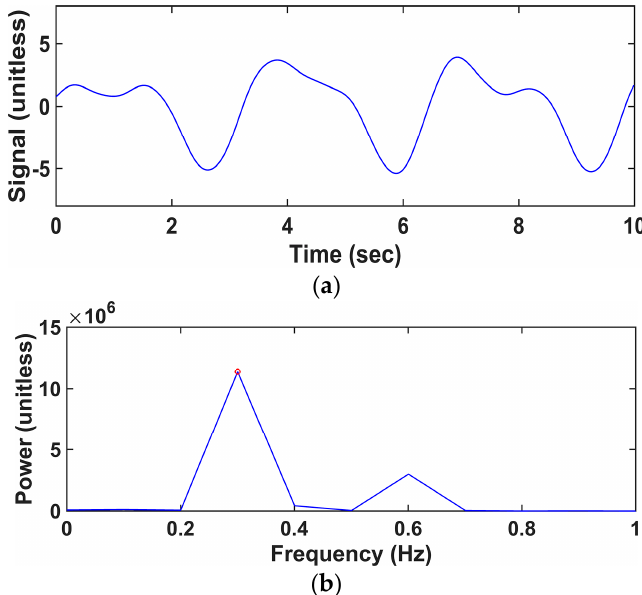
Figure 1. An example of a filtered photoplethysmogram (PPG) signal and its power spectrum: ( a ) PPG signal after filtering (unitless); ( b ) power spectrum (unitless) of (a). A hollow red circle represents a peak of which the power is maximum.